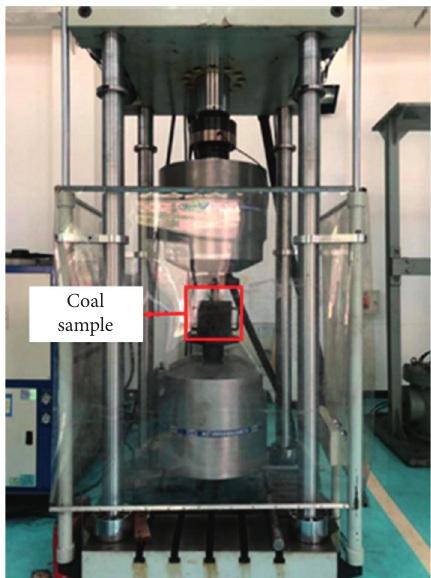
Figure 2: Fatigue-testing